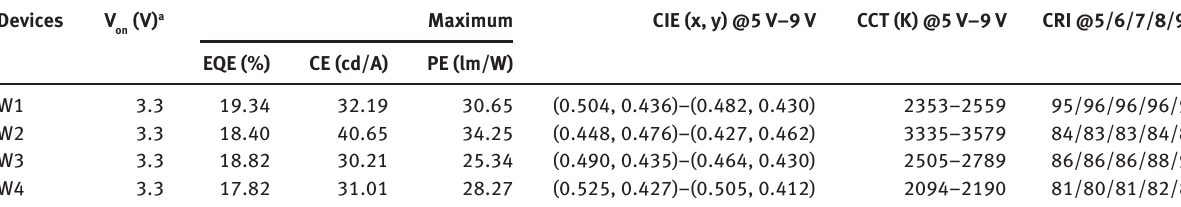
Table 1: Summary of the performances of the four